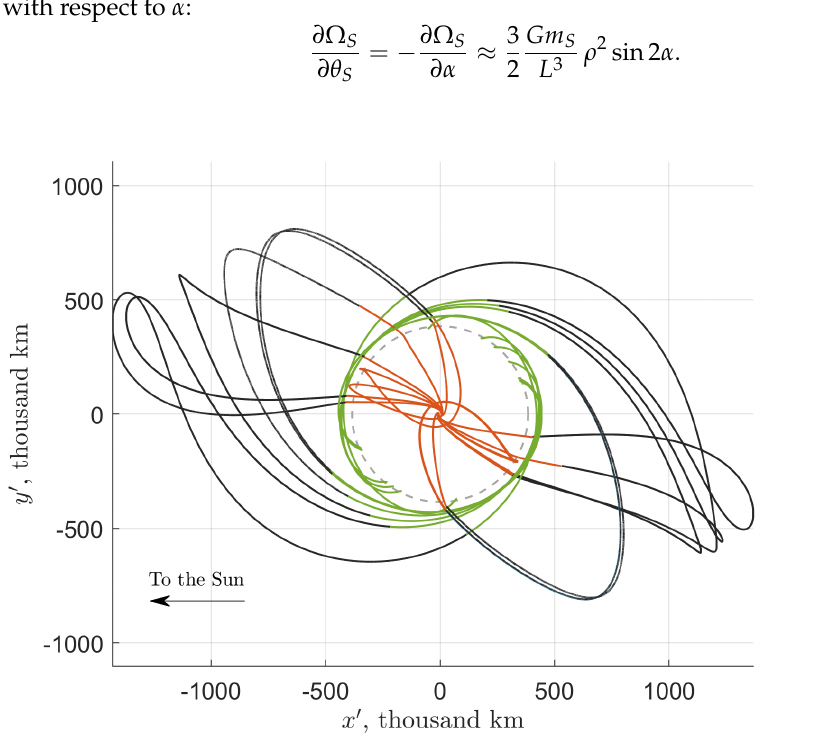
Figure 4. Examples of planar SALT trajectories in the BR4BP with the departing (red), arriving (green) and exterior (black) legs patched on the boundary of the Earth–Moon region of prevalence. The orbit of the Moon is marked by the dashed gray line. The apogee of every SALT trajectory in the Earth-centered Sun–Earth rotating frame is located in the 2nd or 4th